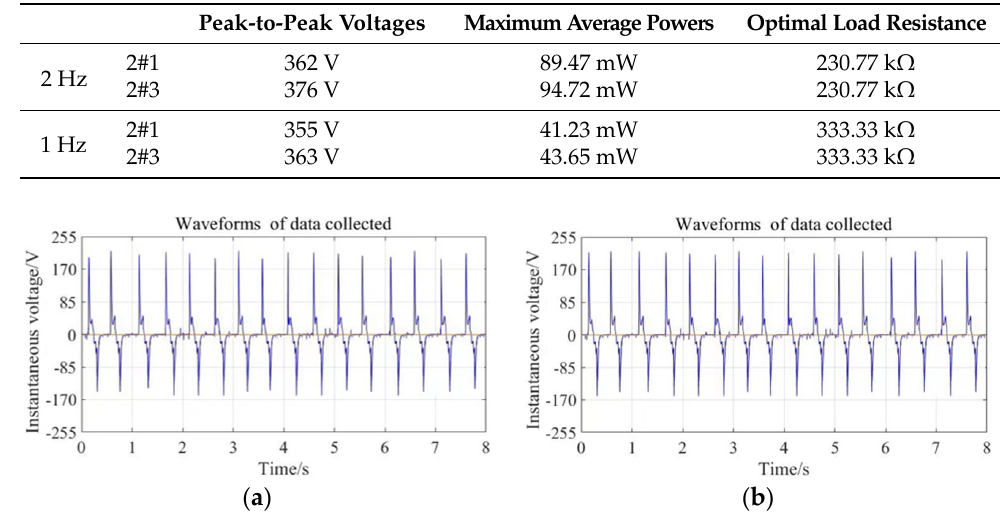
Figure 16. Reported voltages from 2#1 and 2#3 PZT4 patch on unimorph PCS1 and PCS2 of 2# piezoelectric brick ( F = 500 N, f = 2 Hz, and L = 33.5 mm). ( a ) 2#1 PZT4 patch on PCS1; ( b ) 2#3 PZT4 patch on PCS2.